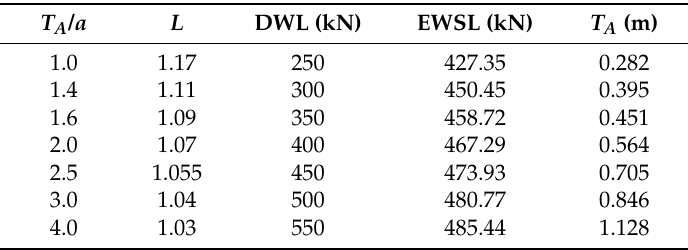
Table 4. Data to draw the ESWL curve.